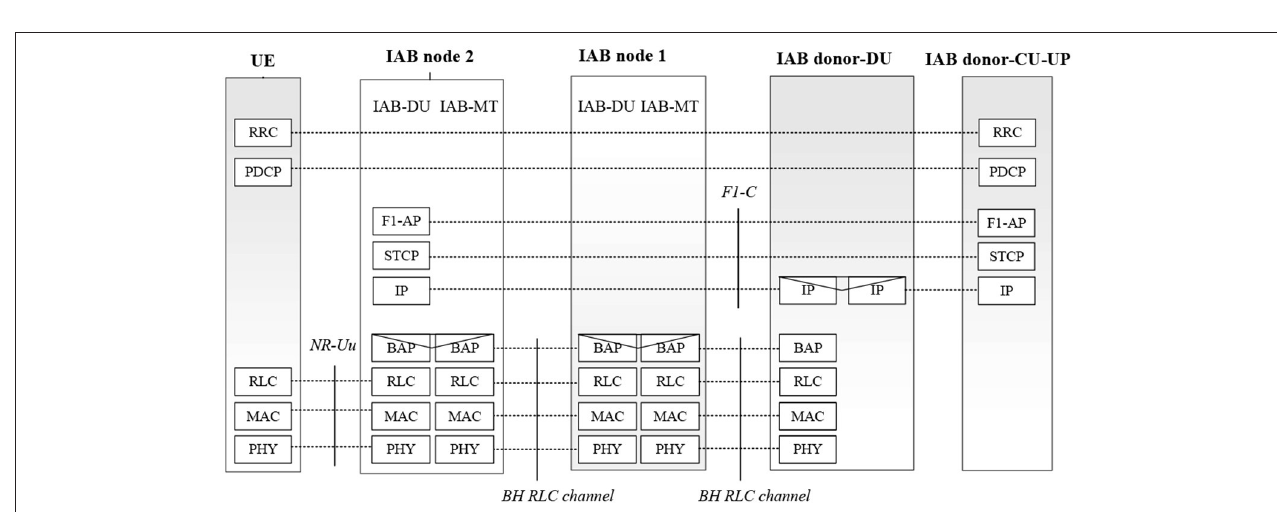
FIGURE 3 | Integrated access and backhaul user plane protocol stack according to 3GPP (2020a).